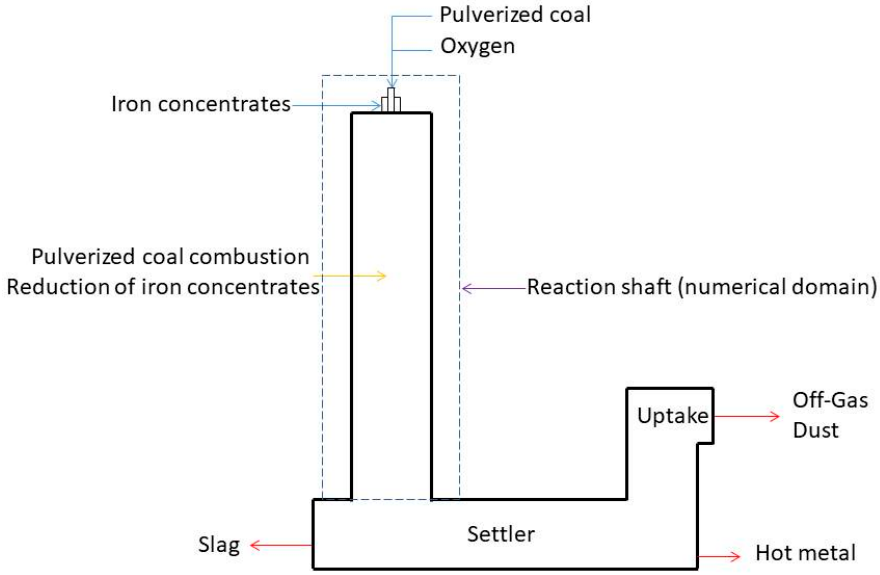
Figure 1. Schematic of the flash ironmaking furnace.